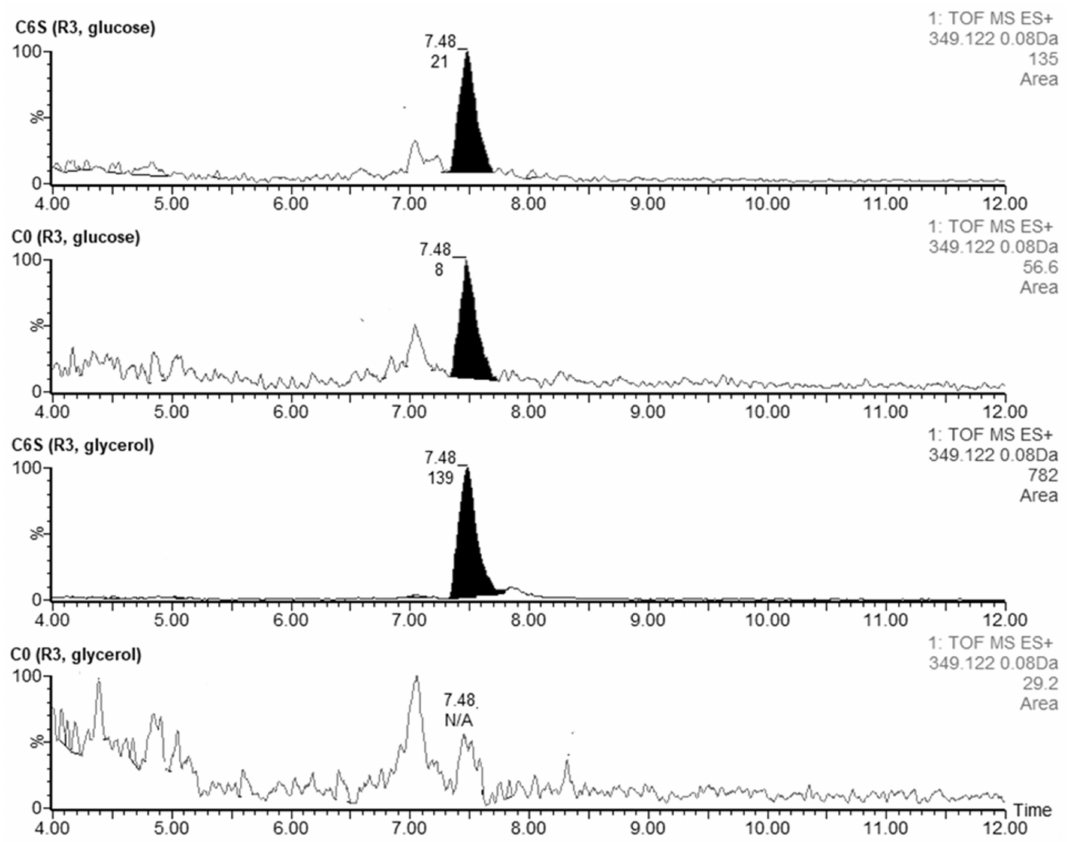
Figure 9. Extracted LC-MS chromatograms of coelimycin P1 produced by S. coelicolor C6S and C0 after 48 h of cultivation in R3 medium with glucose or glycerol. Table 2. Color heat map represents the range of gene expression change in the C6S strain relative to the C0 strain from most down-regulated (dark purple) to most up-regulated (dark maroon) genes. Gene SCO